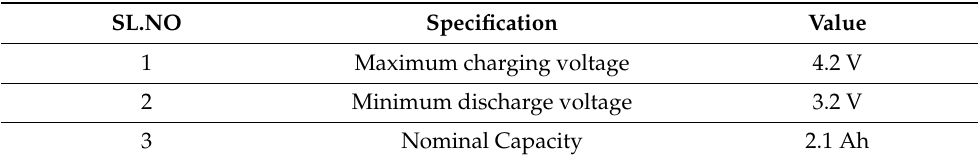
Table 2. Specifications of Li ion 18650